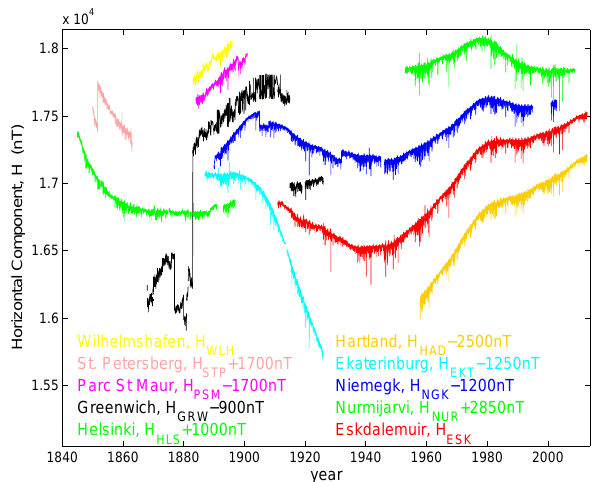
Fig. 1. Daily means of the horizontal component of the field, H , measured at the observatories listed in Table 1: red is Eskdalemuir, ESK; blue is Niemegk, NGK; green is Helsinki, HLS and (after 1952) Nurmijärvi, NUR; orange is Hartland, HAD; mauve is Parc St Maur, PSM; cyan is Ekaterinburg, EKT; black is Greenwich, GRW; yellow is Wilhelmshaven, WLH and pink is St Petersburg, SPE. Note that offsets have been introduced to reduce the y scale needed to display all the